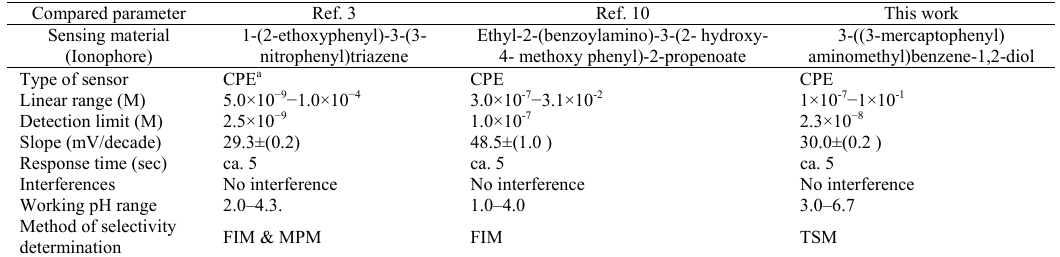
Table 4. Comparison of the characteristics of the proposed sensor with those of the previously reported Hg 2+ sensor. Compared parameter Ref. 3 Ref. 10 This work Sensing material